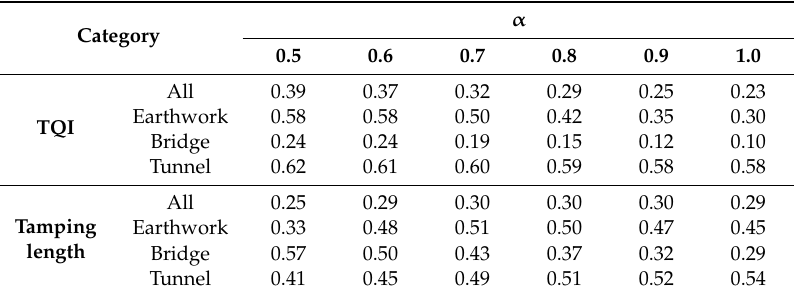
Table 5. R 2 according to α